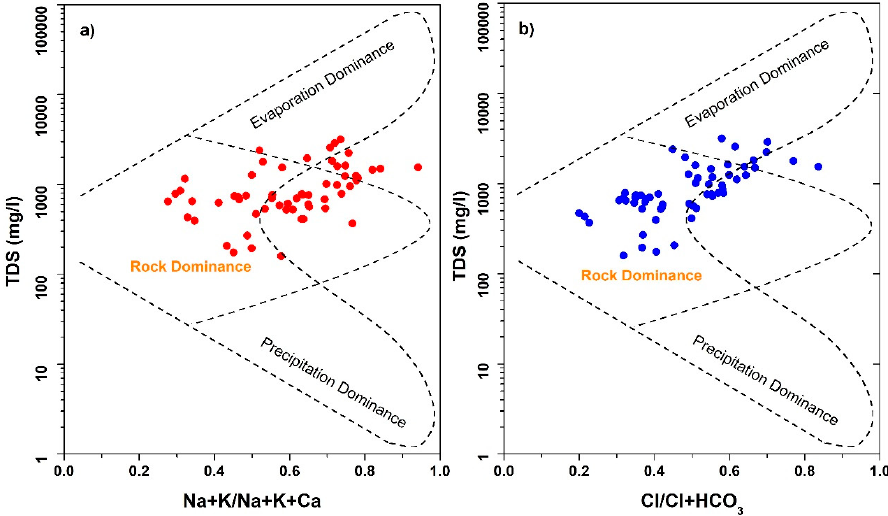
Figure 8. Gibbs plot showing major processes controlling groundwater chemistry.